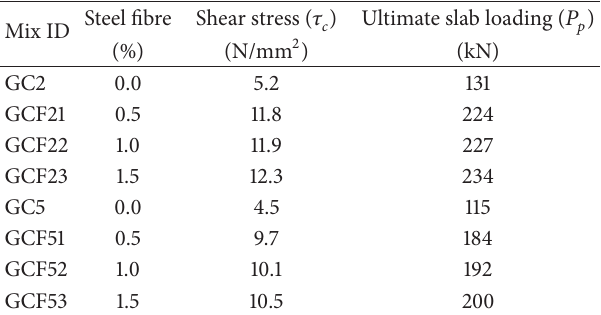
Table 6: Shear stress for various percentage of steel fibre and its ultimate load